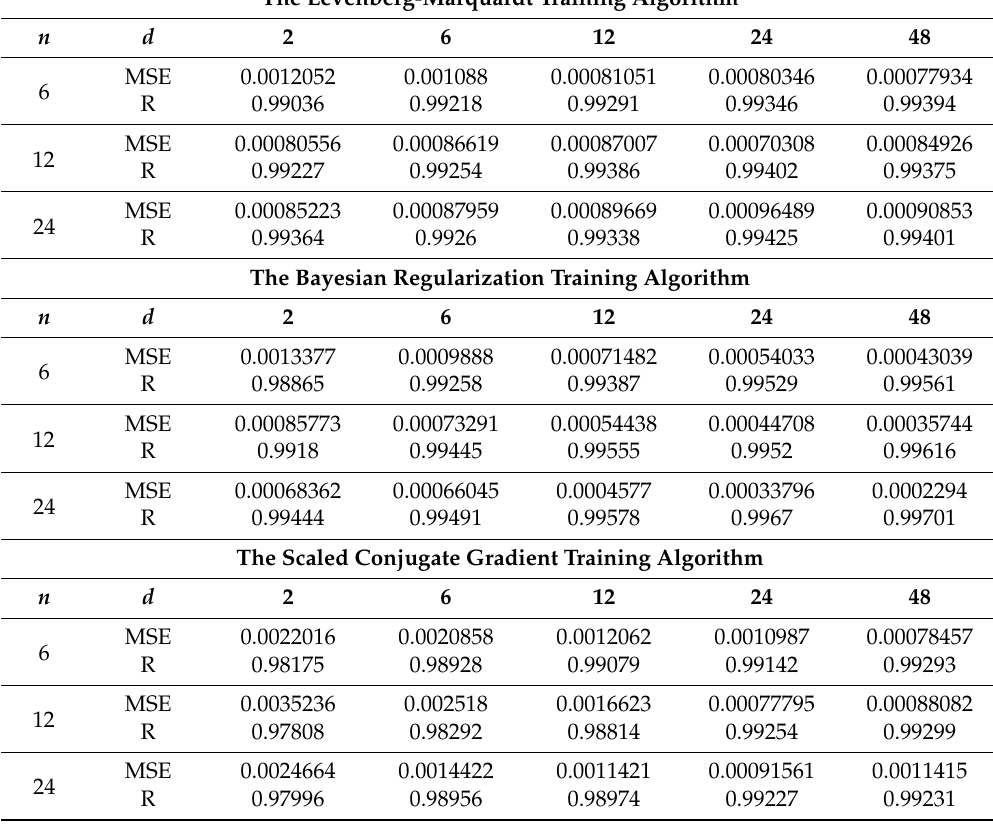
Table 3. The synthesis of the experimental results when developing the artificial neural networks forecasting solution based on the NARX model, using as exogenous variables the meteorological and the time stamps